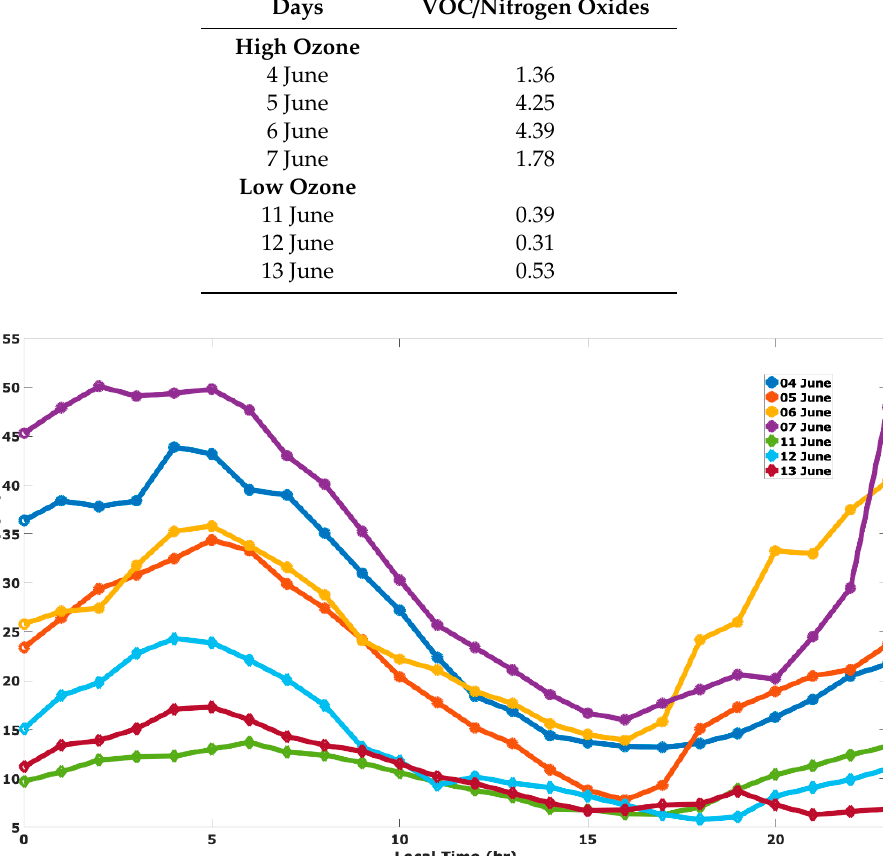
Table 4. Average VOC / NO x ratio for both high and low ozone episodes.